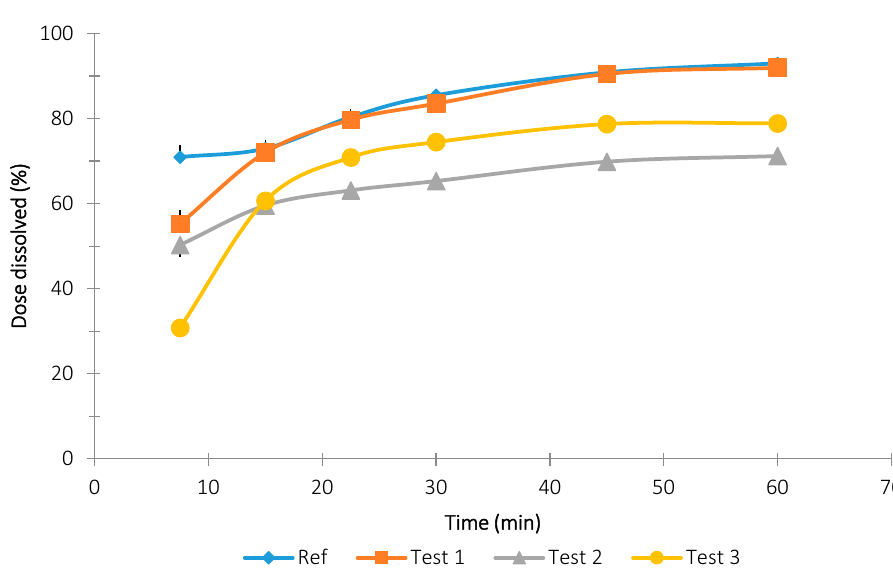
Figure 3. Mean dissolution results and standard deviation obtained with the rotational paddle dissolution equipment at 4.5 pH with 1.5% w / v SDS.